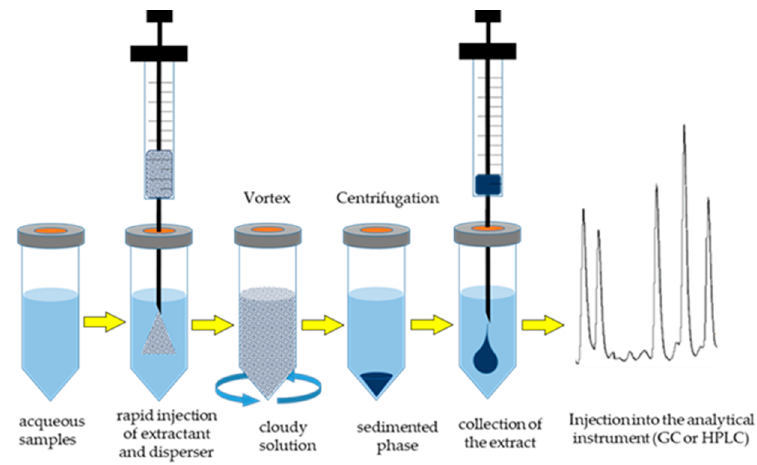
Figure 2. Schematic representation of dispersive liquid-liquid micro-extraction (DLLME).